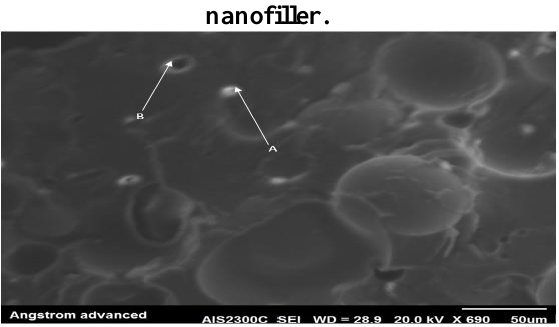
Figure 4: SEM of the fractured impact surface reinforced by 2% SiO SiO nanofiller. B, pore. 2